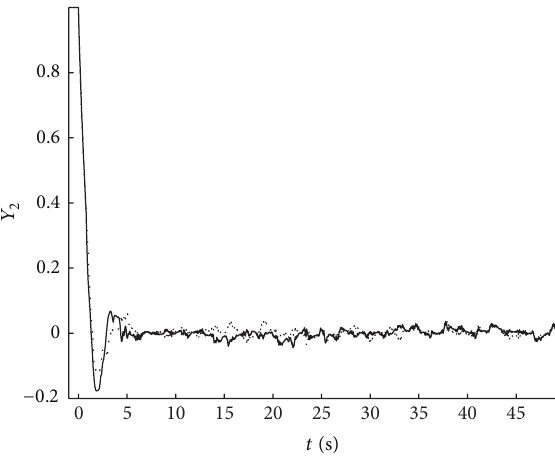
Figure 4: Time response of the output variable 𝑌 2 (𝑡)